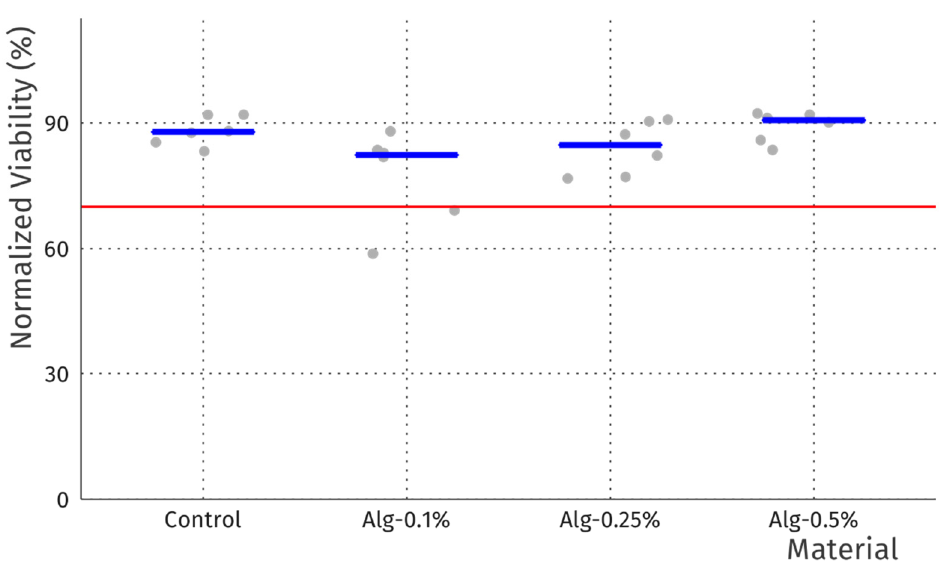
Figure 10. Cell viability data normalized to sham control (no disc) for alginate films with MEL and control film without MEL. Grey dots represent individual samples (n = 6), while blue bars indicate median values. Red line marks the 70% viability threshold of ISO10993-5.